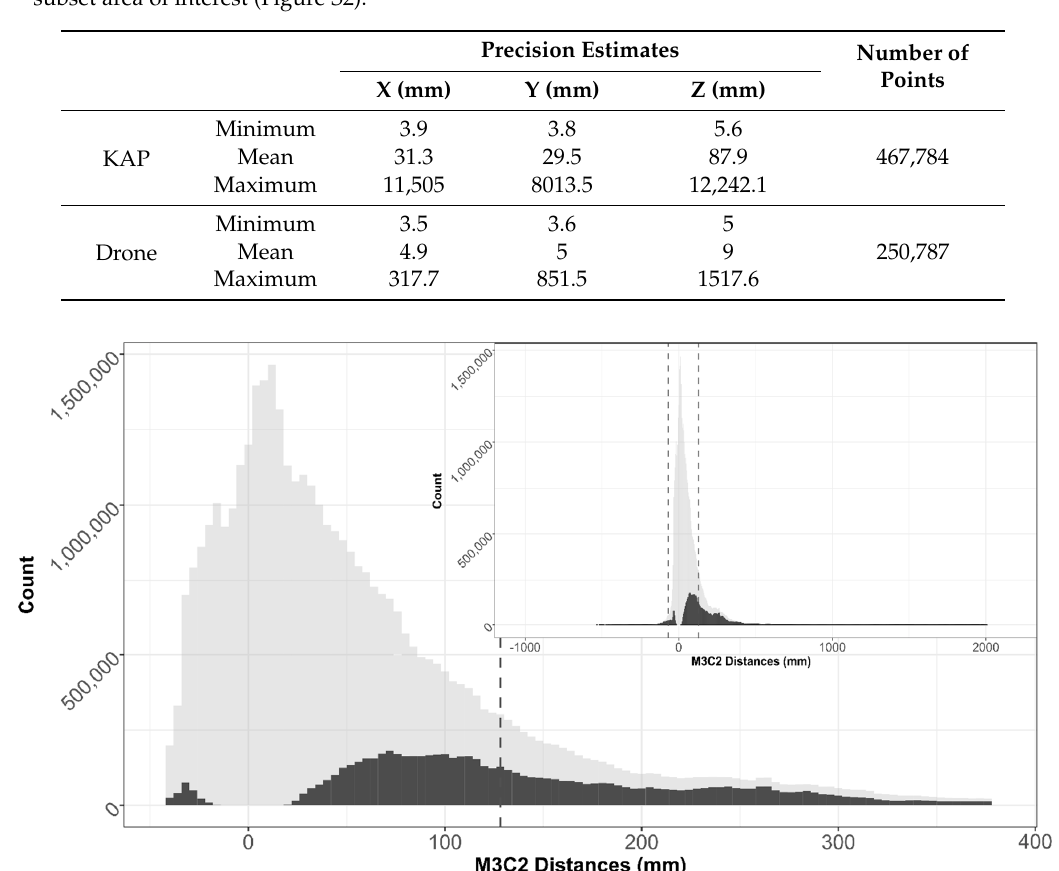
Figure 7. Distribution of M3C2 distances between the kite survey and drone survey. Main figure shows data cropped to 5% and 95% quantiles with inset histogram showing all data. Points falling outside the common area between surveys have been removed, as they cannot be used in M3C2 analysis. Point cloud exported at native resolution of drone derived point cloud. Light grey shows all points in the change cloud and darker grey indicates significant changes in distance. Dashed lines indicate the positive (128 mm) and negative ( − 56 mm) median values of significant